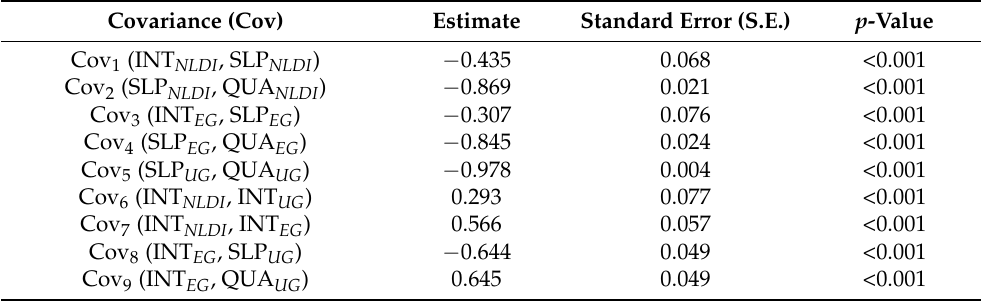
Table 3. Standardized model estimates for Education Gini (EG), Urban Population Gini (UG), and Nighttime Light Development Index (NLDI) based on intercept (INT), slope (SLP), and quadratic (QUA) growth parameters. Covariance (Cov) Estimate Standard Error